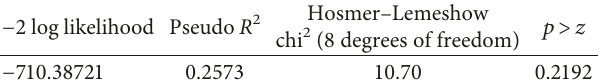
Table 2: Model fitting and amount of variation explained by the model ( N � 1446).